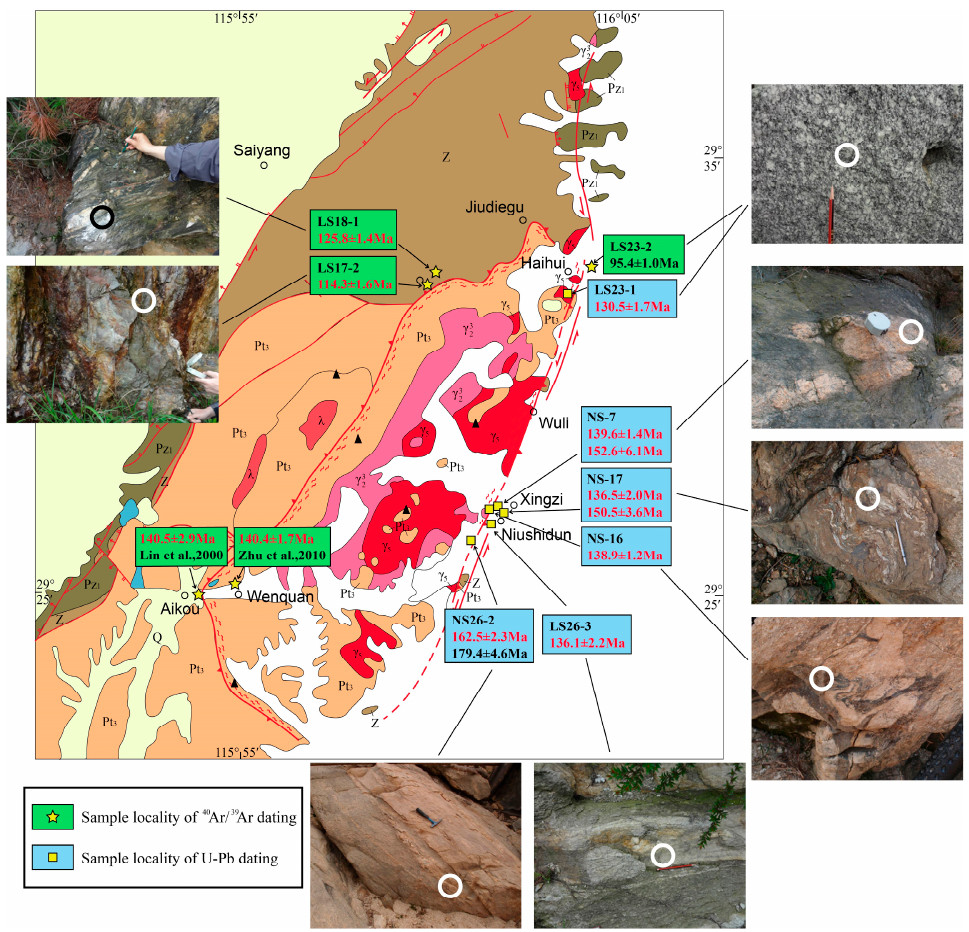
Figure 8. Geological map of the Lushan area with the isotopic dating results and sample localities (the legend is the same as in Figure 1). White circles indicate the local sampling positions.